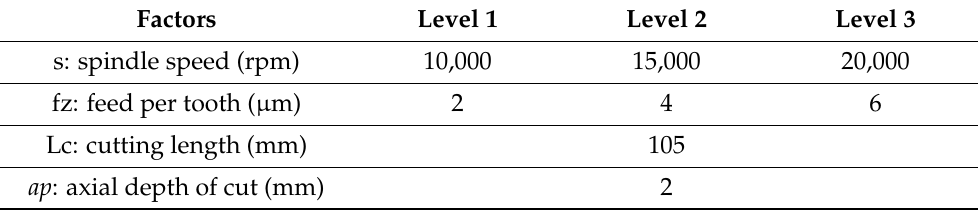
Table 4. Machining parameters and selected levels.